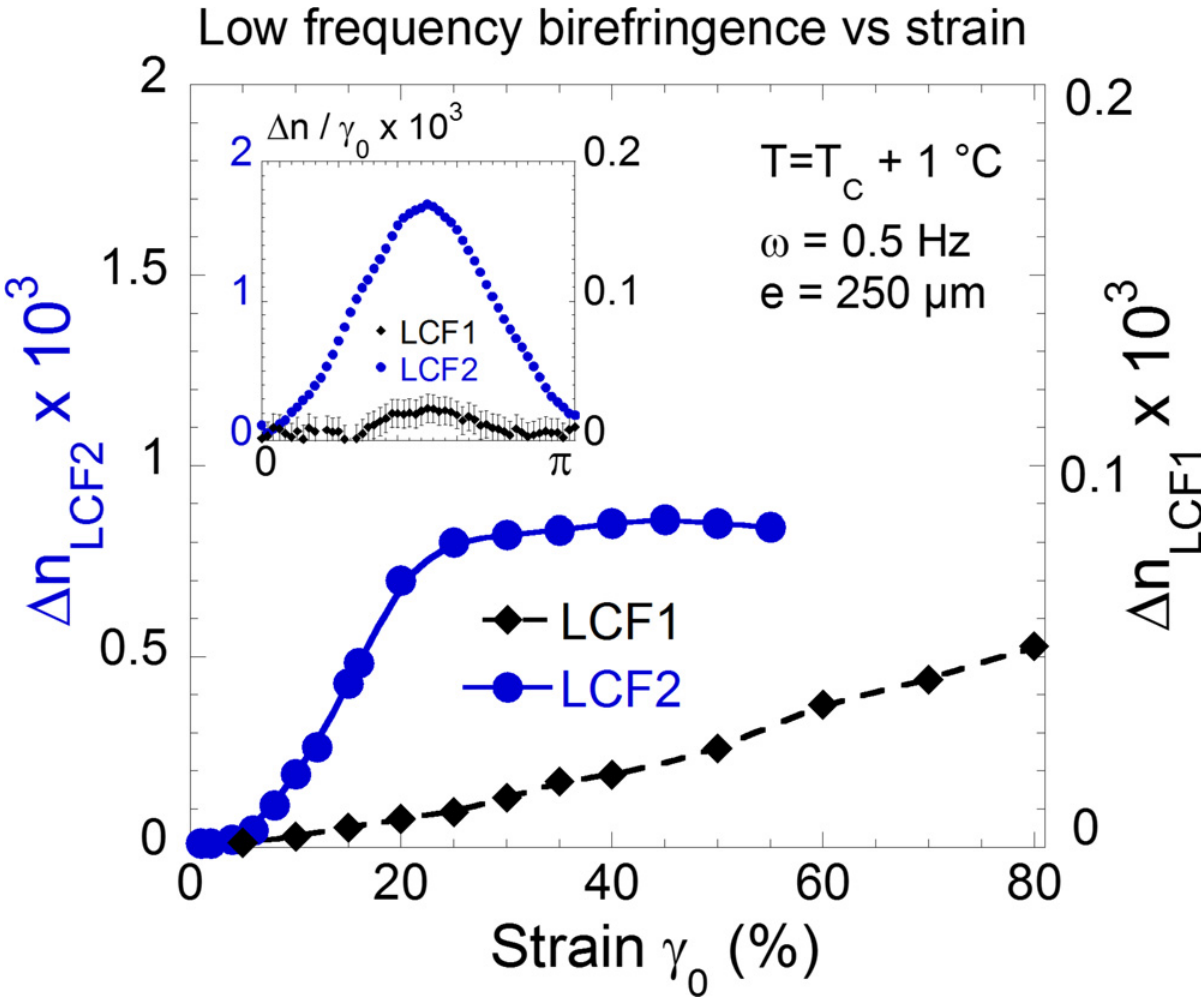
Fig 4. The small molecule LCF2 produces a stronger birefringence at low frequencies: Comparative intensities of the low frequency birefringence (peak values) displayed in the isotropic phase by LCF1 (black diamonds, ♦ ) and by the small molecule LCF2 (blue dots, ● ) under the same conditions ( ω = 0.5Hz, 250 μ m, +1°C above the isotropic transition) versus the strain amplitude γ 0 . The lines serve as eye-guides. Insert: Comparison of the optical wave signals of the isotropic phase of LCF1 and LCF2 at γ 0 = 10% (double scale — the birefringence is normalized to the strain